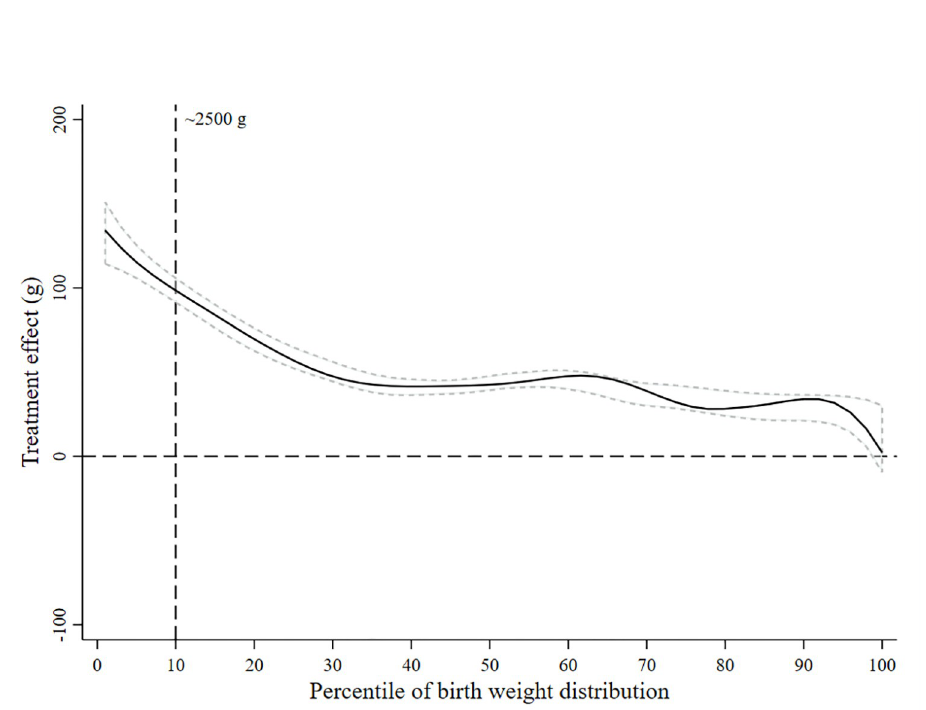
Fig 2. Treatment efficacy on birth weight across the distribution of birth weight. The estimated difference in birth weight between the women who received the BEP supplement and IFA (intervention) and those who received only iron and folic acid (control) is shown as a function of the percentiles of birth weights. The zero line indicates no efficacy of BEP. The positive y values indicate a higher birth weight in the intervention group, and the negative y values indicate a lower birth weight. The central solid black line represents the smoothed treatment efficacy, with upper and lower dashed 95% confidence bands, using complete cases. BEP, balanced energy–protein; IFA, iron–folic